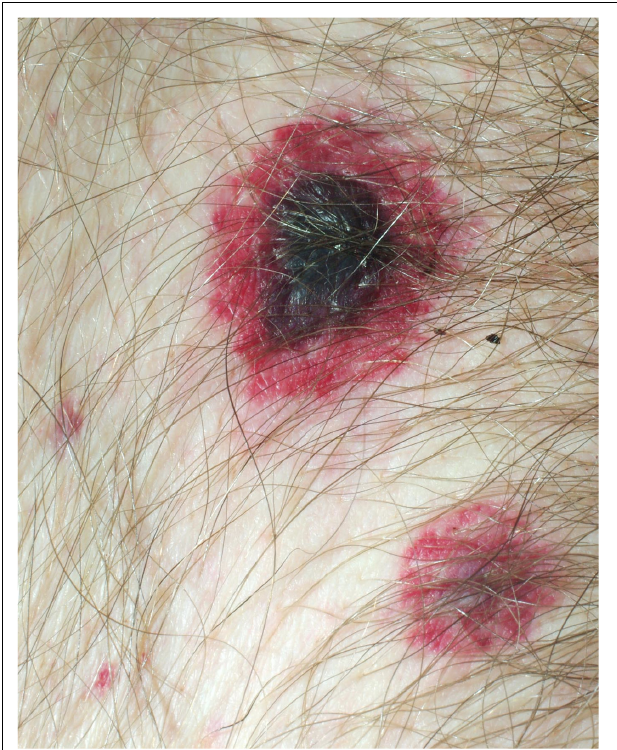
FIGURE 1 | Photograph of a suprapubic ecthyma gangrenosum lesion. Notice the necrotic center of the large lesion, with an erythematous halo. The smaller lesion is presumed to be of an earlier